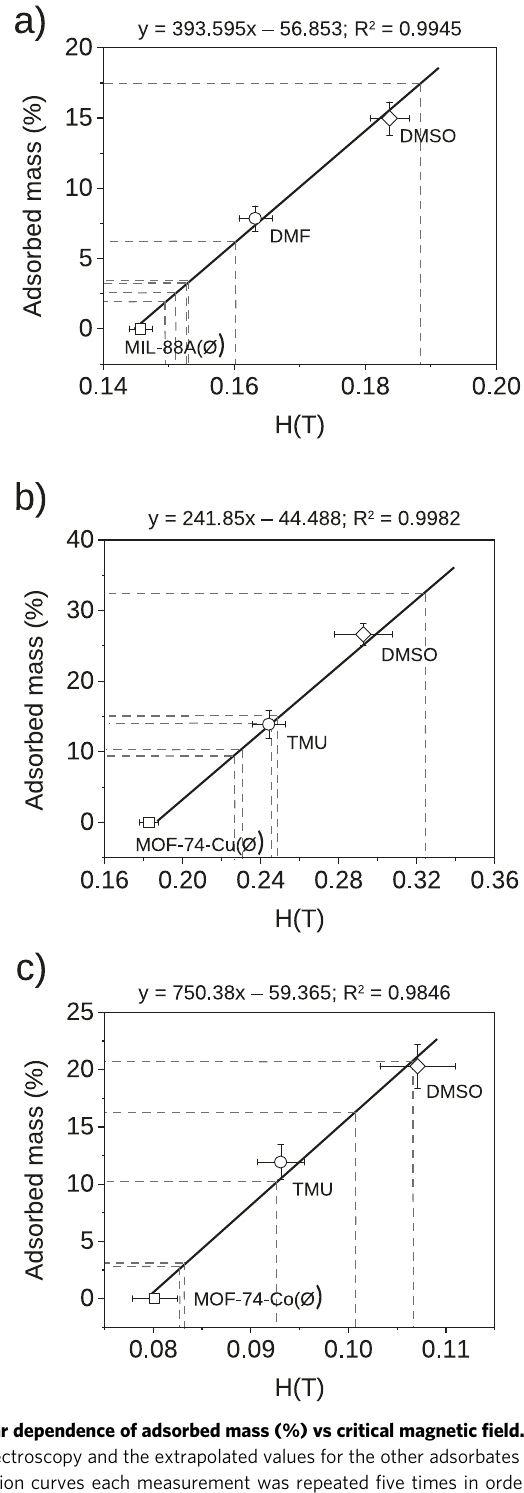
Acros Organics. Cobalt(II) nitrate hexahydrate (Co(NO 3 ) 2 ·6H 2 O, 98%) was purchased from Roth, 2,5-dihydroxiterephthalic acid (DHTPA) and tetra-